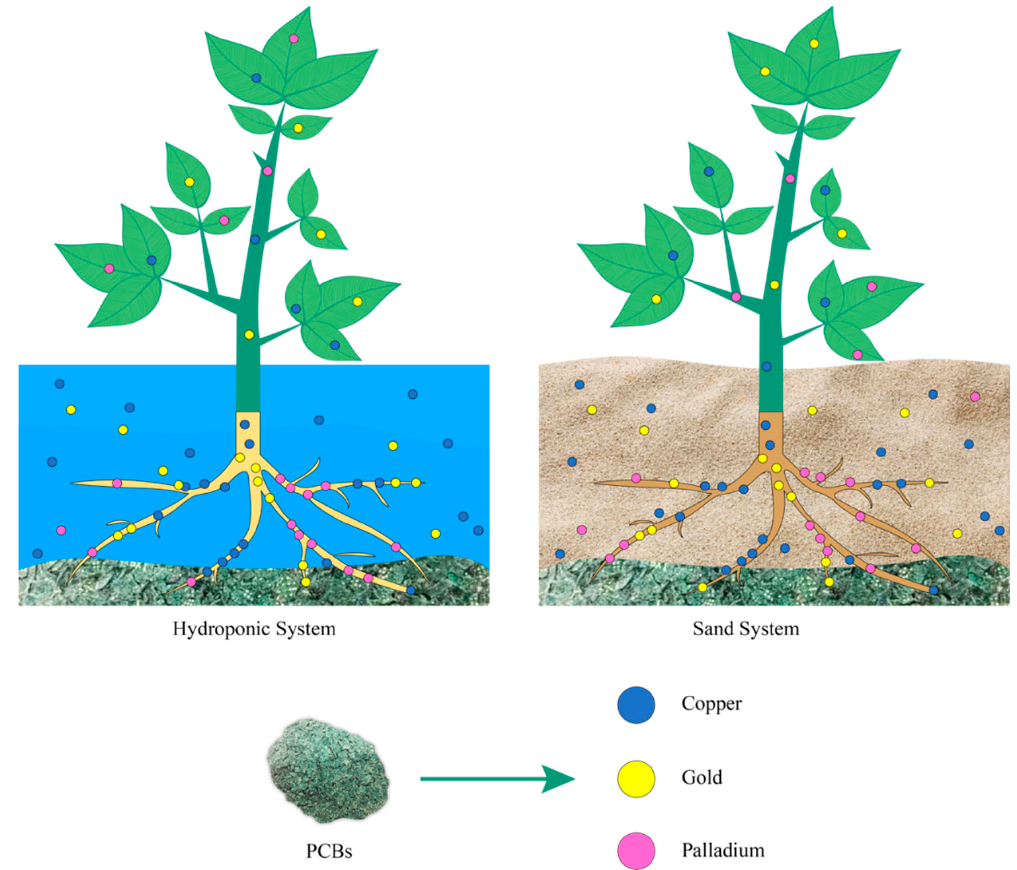
Figure 4. Accumulation of Cu, Au, and Pd from the PCBs of computers and cell phones in the roots of plants grown in a hydroponic system and in a sand system. Table 4. Plants used in the recovery of metals from PCB of computers and cell